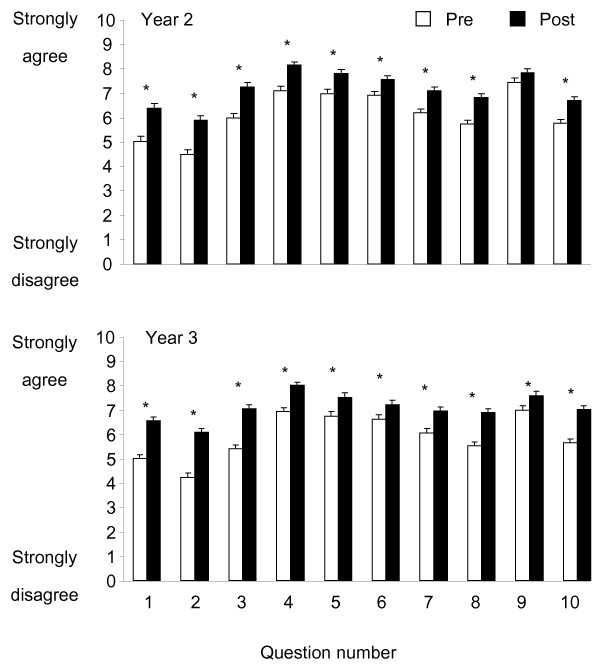
Junior students self-reported constructs pre and post the standardised patient interaction. Figure Legend: Mean ratings by junior students collapsed across courses in Year 2 and Year 3 for each of the 10 survey questions administered pre and post the standardised patient interaction. Error bars denote standard deviation.